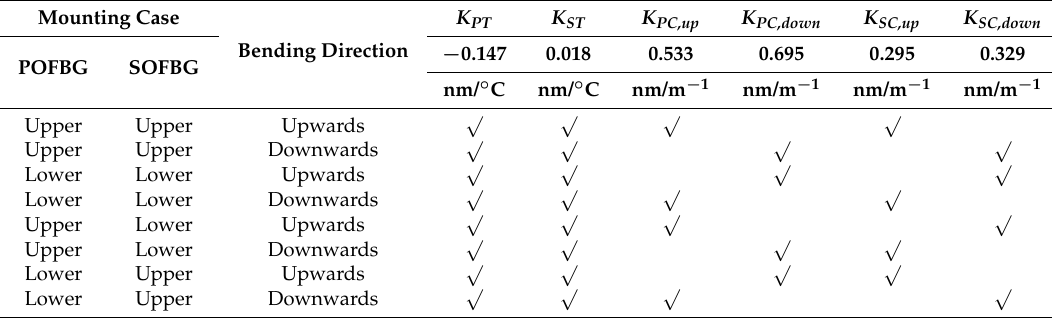
Table 6. Parameters of the simultaneous vector bending and temperature sensing for different